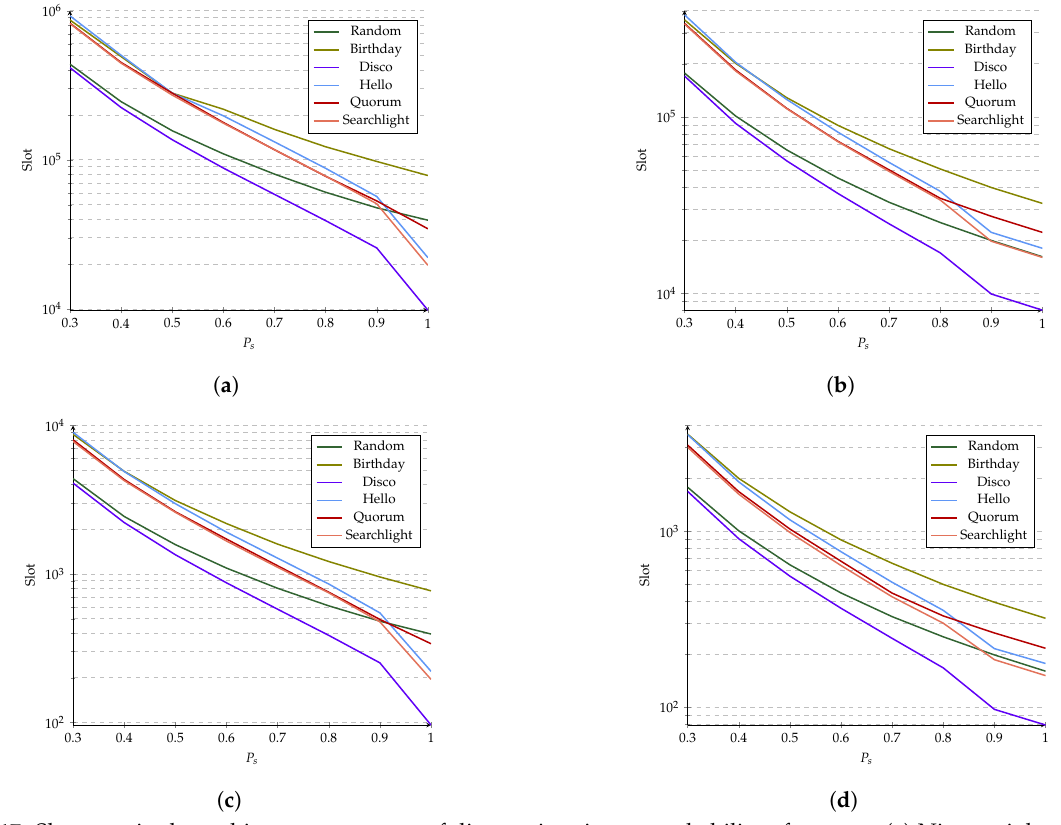
Figure 17. Slots required to achieve a percentage of discoveries given a probability of success. ( a ) Ninety-eight percent of coincidences with 1% duty cycle. ( b ) Eighty percent of coincidences with 1% duty cycle. ( c ) Ninety-eight percent of coincidences with 10% duty cycle. ( d ) Eighty percent of coincidences with 10% duty